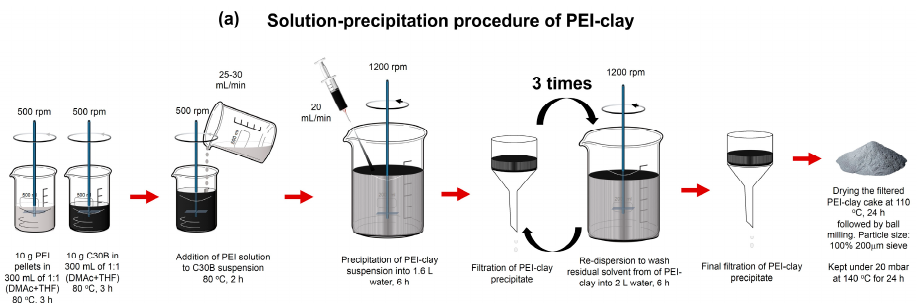
Figure 6. Representative transmission electron microscope images of: ( a ) PA6/organoclay; ( b